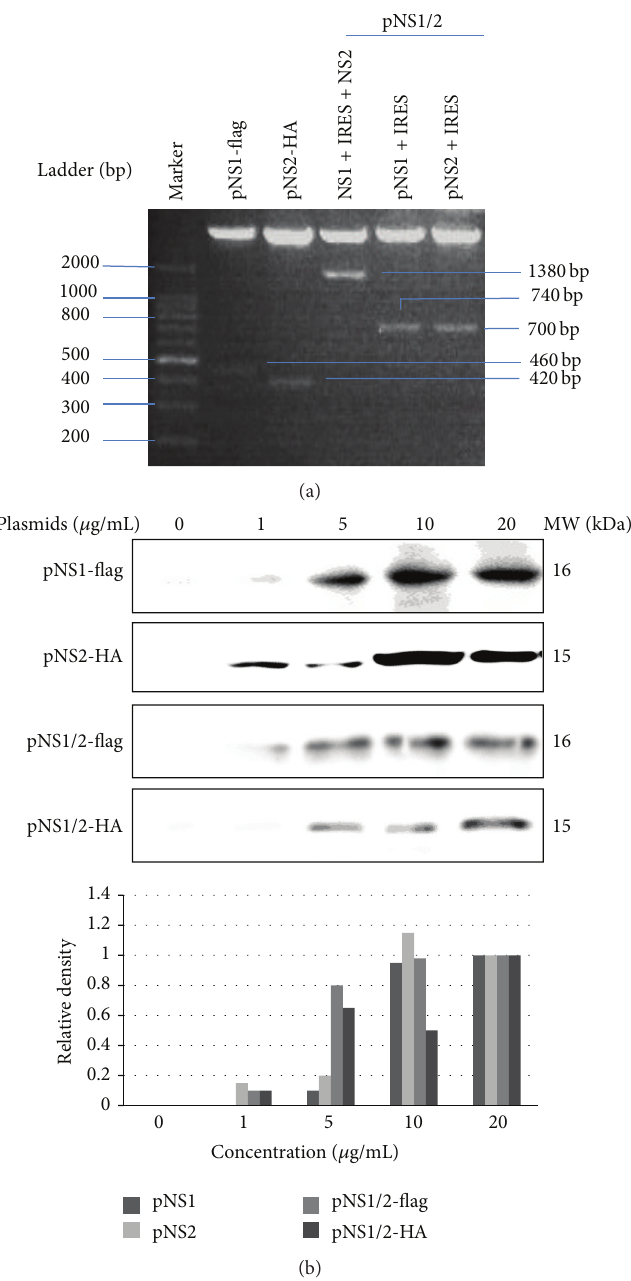
Figure 1: Identification and expression of the reconstituted plasmids pNS1, pNS2, and pNS1/2. (a) DNA gel electrophoresis analysis of the expression plasmids. pcDNA3.1(+) plasmids inserted with NS1, NS2, or NS1/NS2 artificial ORFs were digested with enzymes for 30 min, and the products were separated in a 1% agarose gel. (b) Total cellular extracts were collected from A549 cells at 2 h after plasmid transfection with final concentrations of 0, 1, 5, 10, or 20 𝜇 g/mL, and Western blot was performed to measure protein levels. The data are shown as fold increases in protein density compared with the concentration of 20 𝜇 g/mL, assumed to be